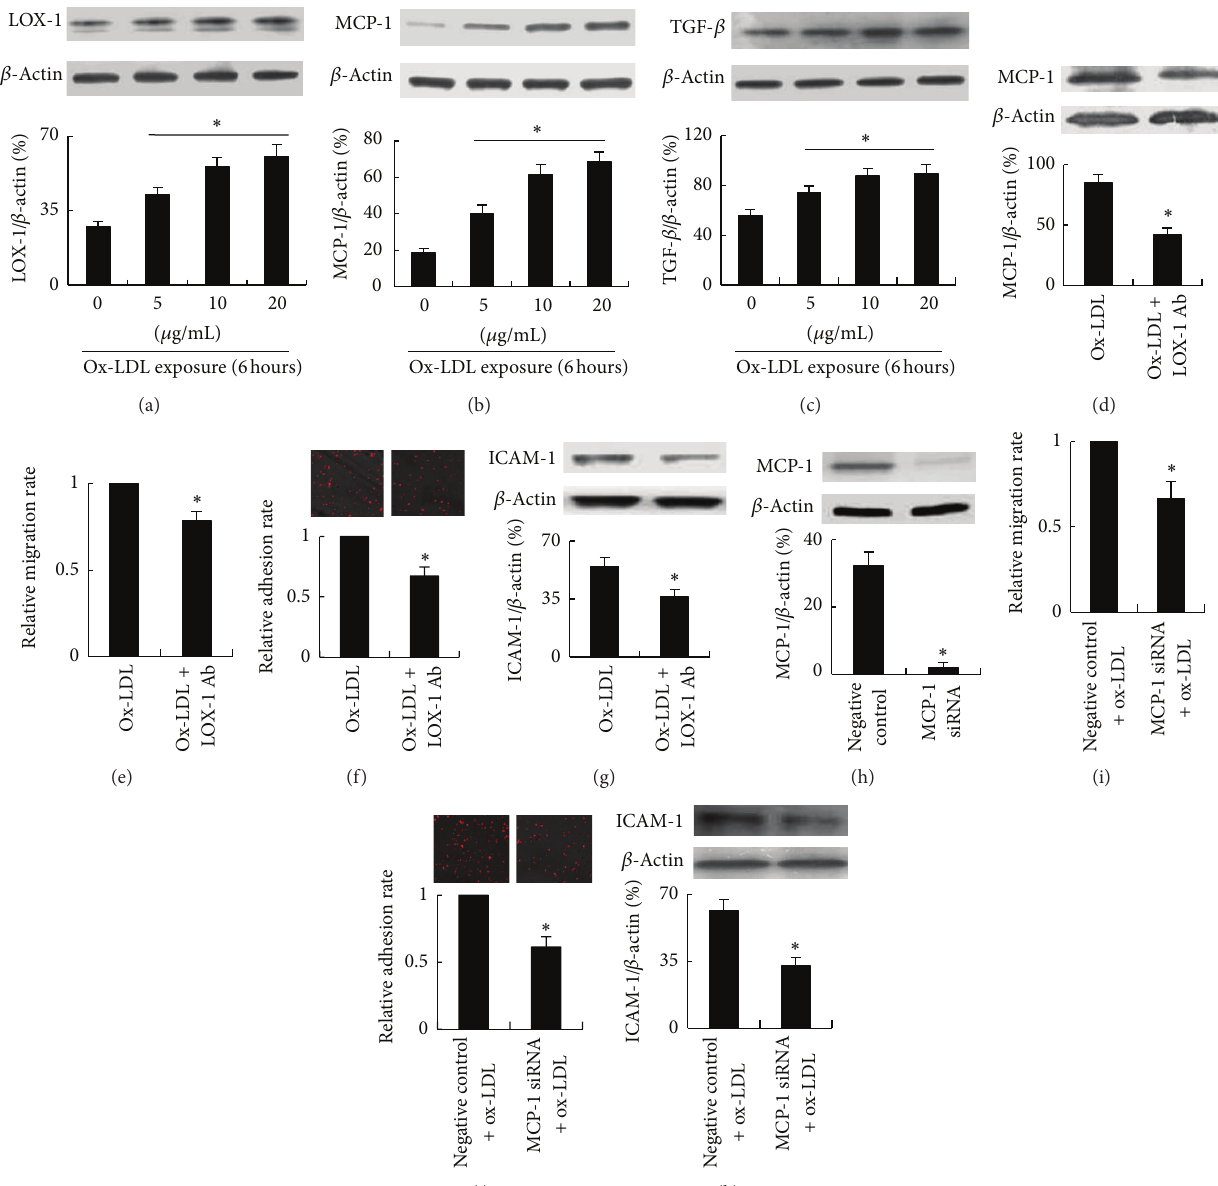
Figure 6: Role of LOX-1 and MCP-1 in ox-LDL-mediated migration and adhesion of bmMSCs. (a)–(c) Western-blotting assay shows LOX-1, MCP-1 and TGF- 𝛽 expression in bmMSCs after exposure to 0, 5, 10, and 20 𝜇 g/mL ox-LDL for 6 hours. (d) Western-blotting assay shows that LOX-1 antibody inhibits ox-LDL-induced MCP-1 expression. (e) Transwell assay shows that LOX-1 antibody inhibits ox-LDL-induced transmigration of bmMSCs. (f) LOX-1 antibody inhibits ox-LDL-induced cell adhesion between bmMSCs and monocytes. (g) Western- blottingassayshowsthatLOX-1antibodydecreasesICAM-1expression.(h)Western-blottingassayshowsMCP-1expressionaftertransfection of noneffective shRNA and MCP-1 shRNA. (i) MCP-1 knockdown inhibits ox-LDL-induced migration of bmMSCs. (j) MCP-1 knockdown inhibits ox-LDL-induced cell-cell adhesion between monocytes and bmMSCs. (k) MCP-1 knockdown decreases ox-LDL-induced ICAM-1 expression. Bar graphs represent mean ± SD ( 𝑛 = 4 per group). ∗ 𝑃 < 0.01 versus control, ox-LDL treatment, or negative control transfection.